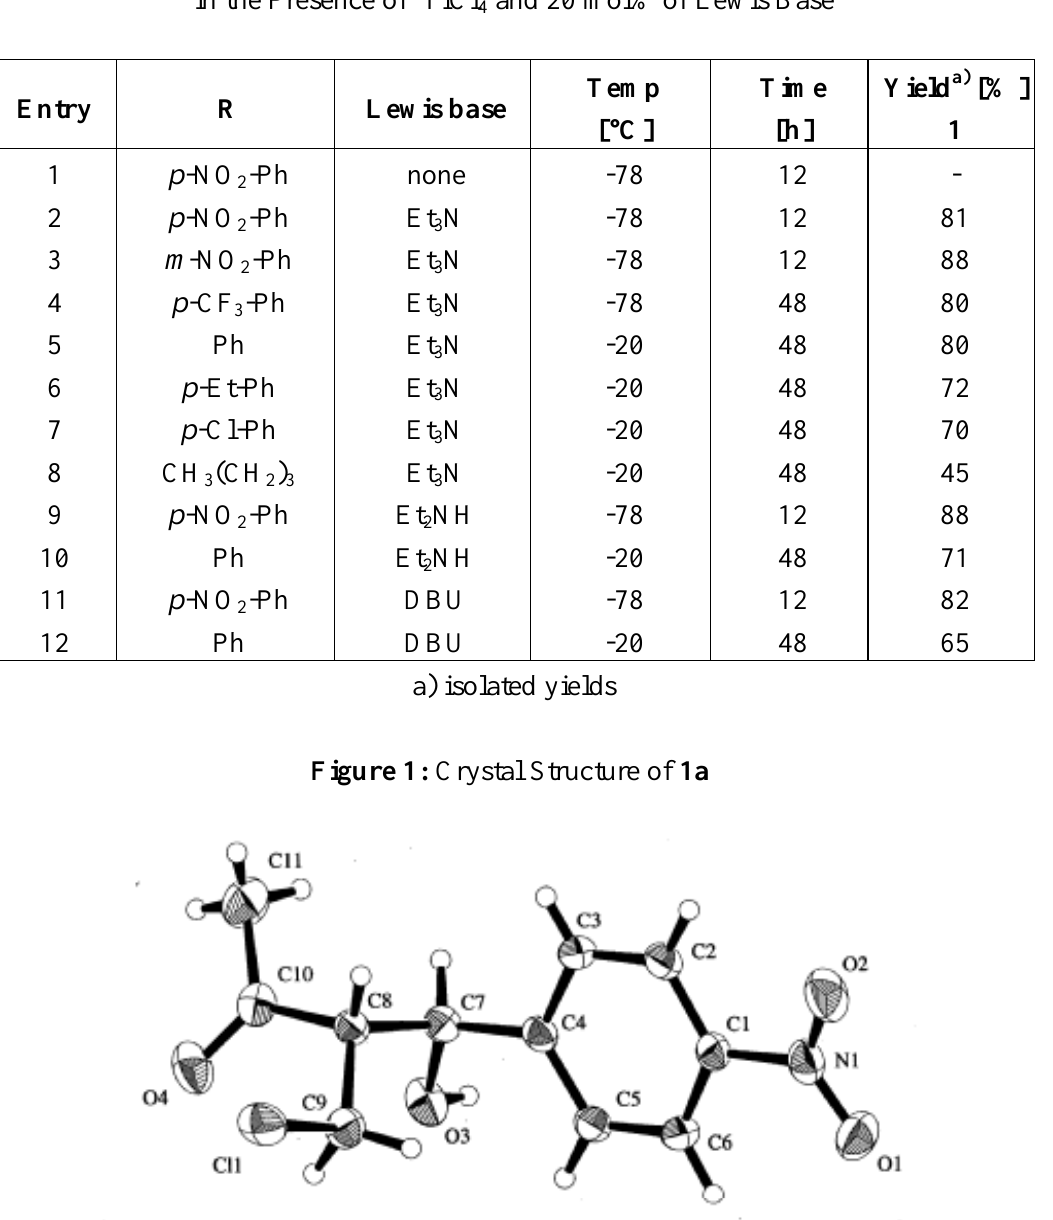
Table 2 . Bayliss-Hillman Reaction of Aldehydes with Methyl Vinyl Ketone